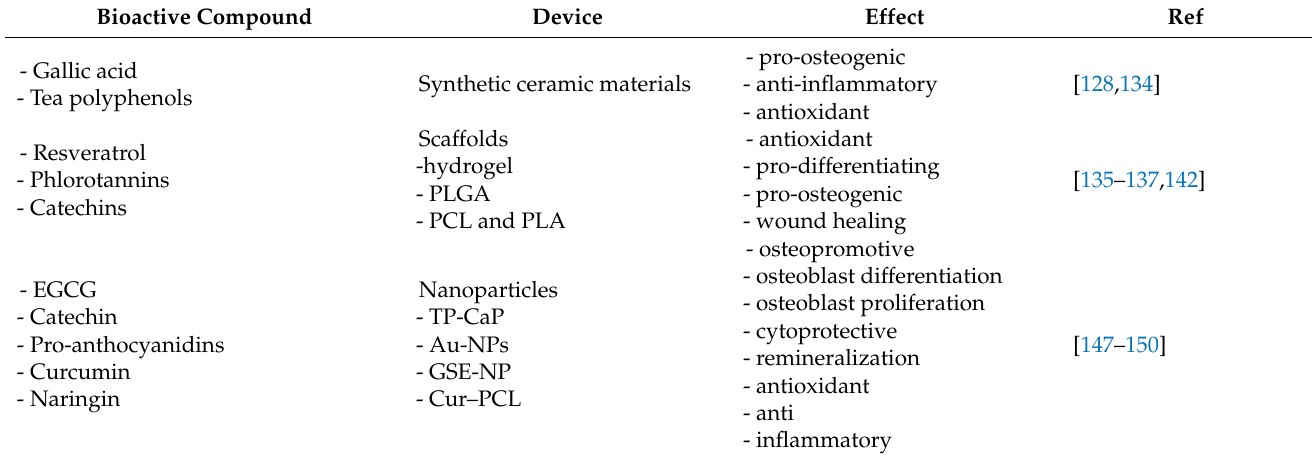
Table 2. Summary of bioactive compounds-based devices system and their effects on bone regeneration. Bioactive